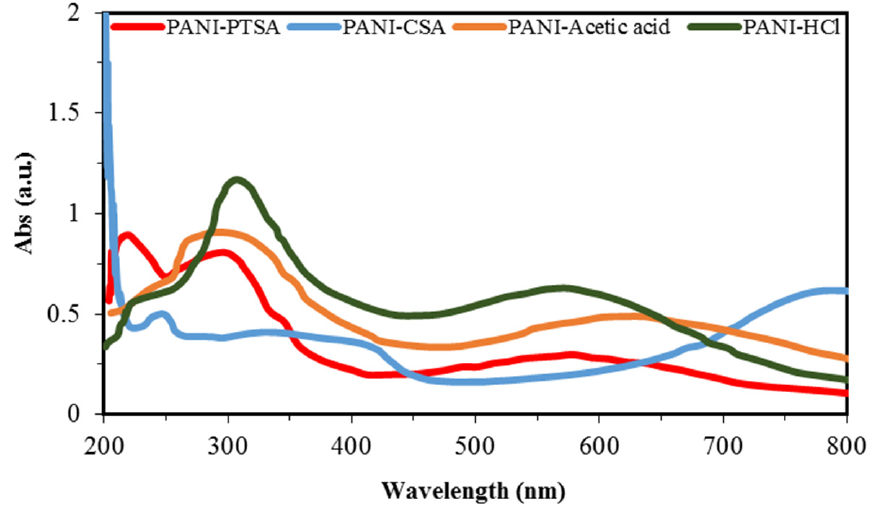
Figure 4. UV-vis spectra of synthesized PANI samples. Bandgaps are energy variations between two bands and are used to determine the optical properties of semiconducting polymers. Low bandgap energy implies smooth π – π * electronic transformation and increased conductivity [58]. The UV spectra of PANI samples exhibit three specific absorption bands across the wavelength regions of 250–320, 320–450 and 450–800 nm. Nitrogen excitation in the benzenoid segments ( π – π * transition) causes the first absorption, and the shift from polaron to π * band and from π to polaron band of the doped PANI chains causes the second and third absorptions, respectively [53,58–60]. Table 6 shows the comparison of absorption rates from the UV-vis spectra of PANI samples. A decrease in absorption band at 578, 579 and 630 nm occurs for PANI-PTSA, PANI-HCl, and PANI-acetic acid, respectively. This phenomenon indicates that the quinoid rings